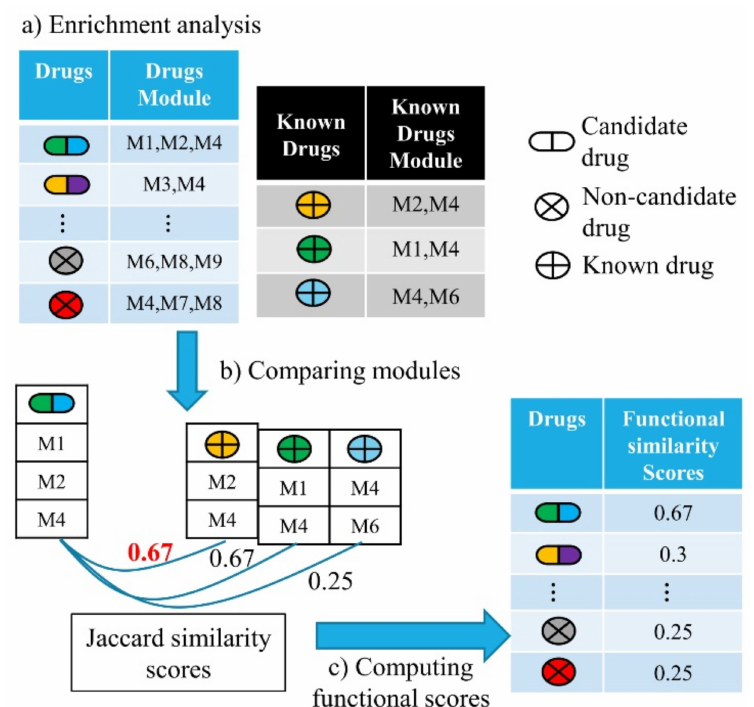
Figure 4. Verification of candidate drug–disease pairs in terms of their functional similarity using a Wilcoxon rank-sum test. ( a ) Enrichment analysis, ( b ) comparison of the functional modules with known drugs, and ( c ) functional score